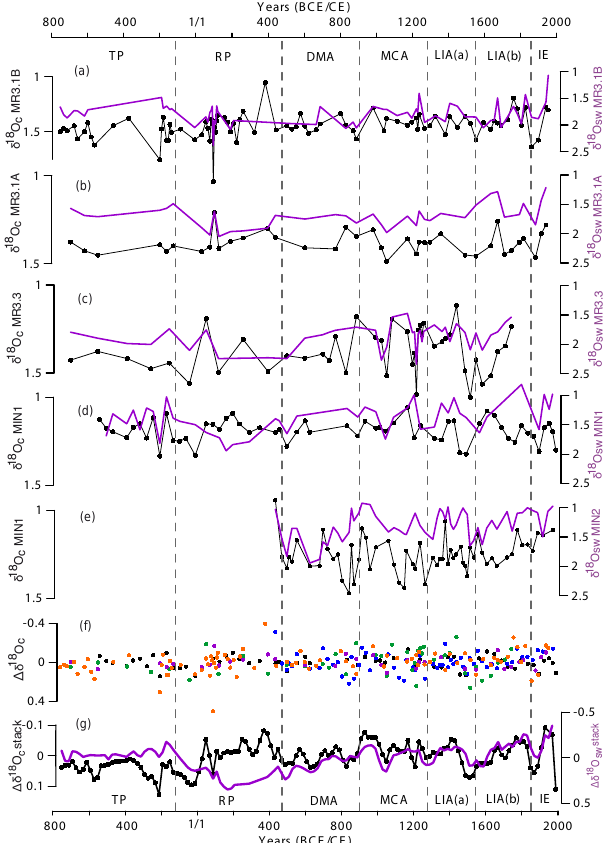
Figure 4. Oxygen isotope measured on carbonate shells of G. bul- loides ( δ 18 O c ‰ VPDB, in black) and their derived δ 18 O sw (pur- ple) for cores: (a) MR3.1B, (b) MR3.1A, (c) MR3.3, (d) MIN2, and (e) MIN1. (f) Individual δ 18 O c (‰ VPDB) anomalies on their re- spective time step. (g) δ 18 O c and δ 18 O sw anomaly stacked records (‰ VPDB and ‰ SMOW,